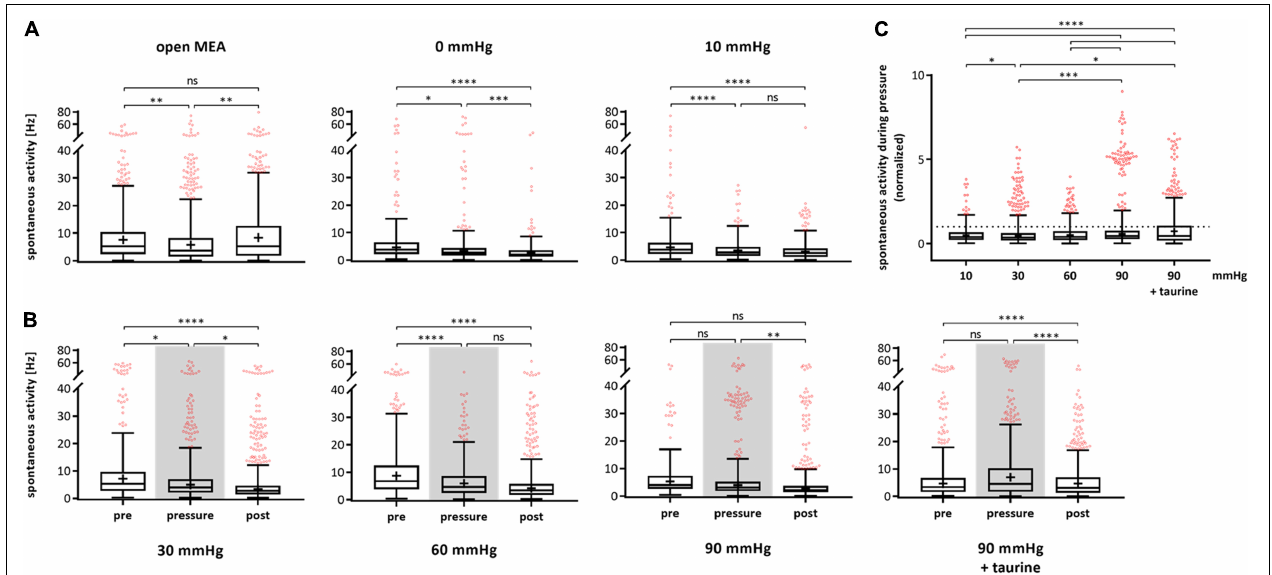
FIGURE 2 | Spontaneous activity of RGCs under different pressure levels. The spontaneous firing frequency [Hz] of RGCs before (pre), during (pressure), and after (post) pressure stress is shown. (A) The results of the control experiments without pressure lid (open MEA), 0 mmHg, and 10 mmHg are presented. (B) The results of the test groups with 30, 60, 90 mmHg, and 90 mmHg + taurine (1 mM) are presented. (C) Summary of the normalized spontaneous RGC activity during pressure is shown. The activity before pressure (pre) was set to 1. Data are presented as box and whisker (min to max) plots. Outliers calculated by ROUT ( Q = 0.1%) are shown as red circles. Mean values of the cleaned data are shown as + . Significant values are indicated by asterisks. Non-significant values are labeled with ns in panels (A,B) and not labeled in panel (C) . One-way ANOVA with post hoc Tukey’s test was performed with GraphPad Prism Software version 7. (A) F (2, 1447) = 6.965, p = 0.0010; F (2, 847) = 18.03, p < 0.0001; F (2, 939) = 24.55, p < 0.0001; (B) F (2, 1370) = 14.95, p < 0.0001; F (2, 1495) = 42.19, p < 0.0001; F (2, 1432) = 6.752, p = 0.0012; F (2, 1550) = 18, p < 0.0001; (C) F (4, 2467) = 20.54, p < 0.0001. n retinae = 5/group, n cells = 152–430/group, n recordings =